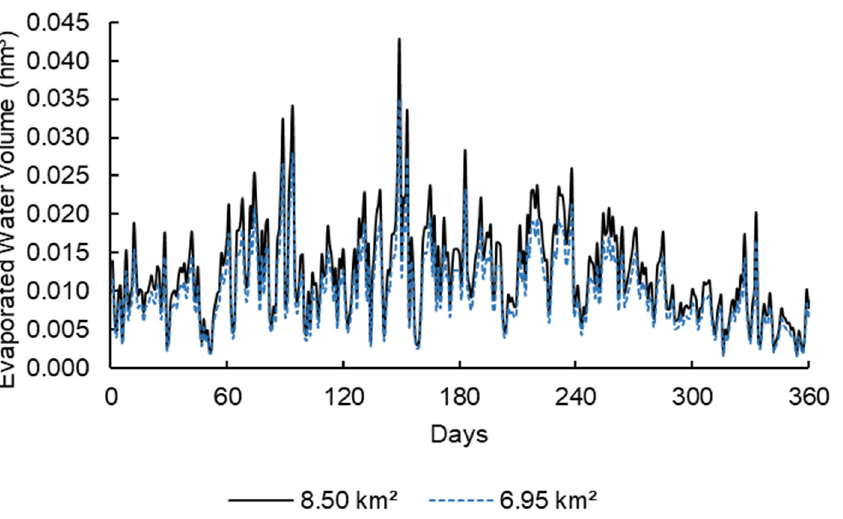
Figure 7. Annual daily volume of evaporated water in the Passaúna reservoir (1 July 2020 to 30 June 2021).